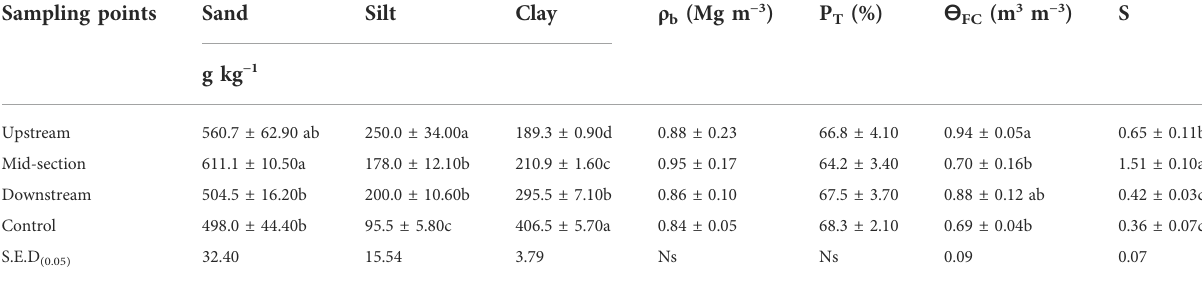
TABLE 1 Soil physical properties of three sampling points along the toposequence of an oil palm mill